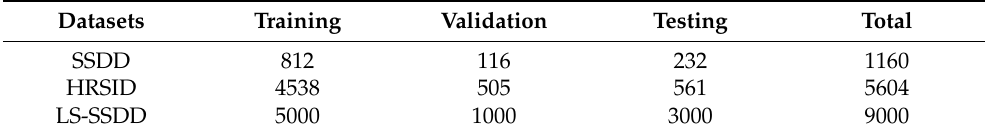
Table 2. Distribution of datasets.